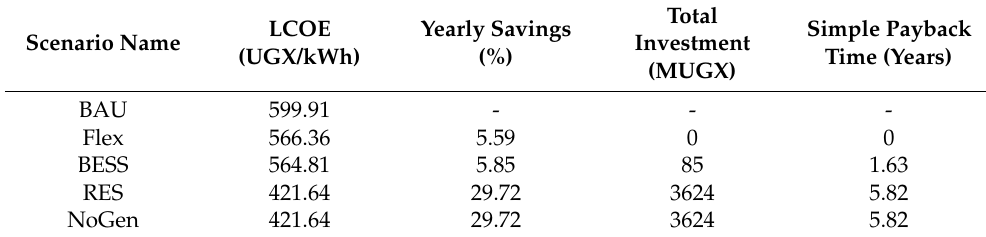
Table 9. Summary of economic results with a higher price of diesel.